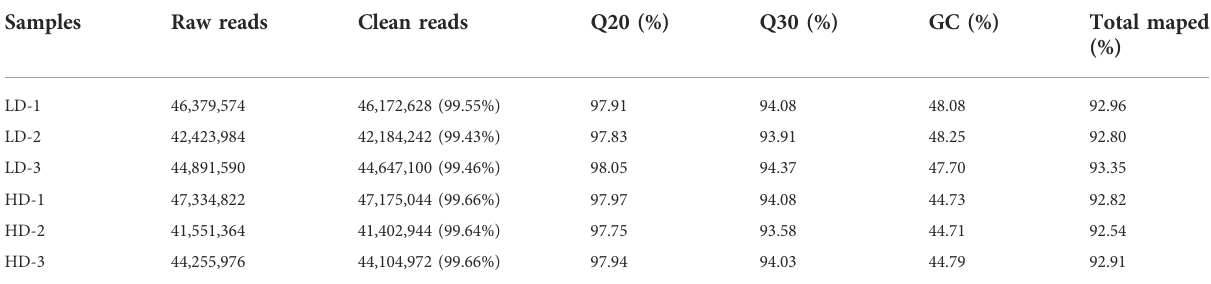
TABLE 1 Valid data used in transcriptome analysis.